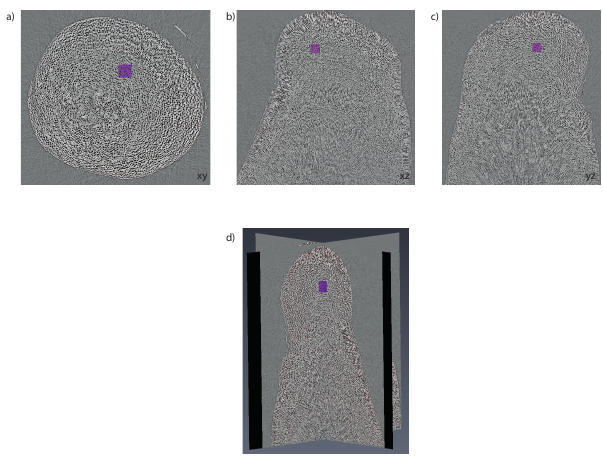
Figure 6. Loads and Boundary constraints. All models had the same loads and constraints applied. Loads, representing wave erosion, were applied to the top left hand corner along a strip 40µm wide at the external top left side of the model (yellow surface). Constraints were applied to the bottom right corner (opposite corner to load) along a strip 40µm wide up the right hand side of the model and over the whole of the bottom model (green